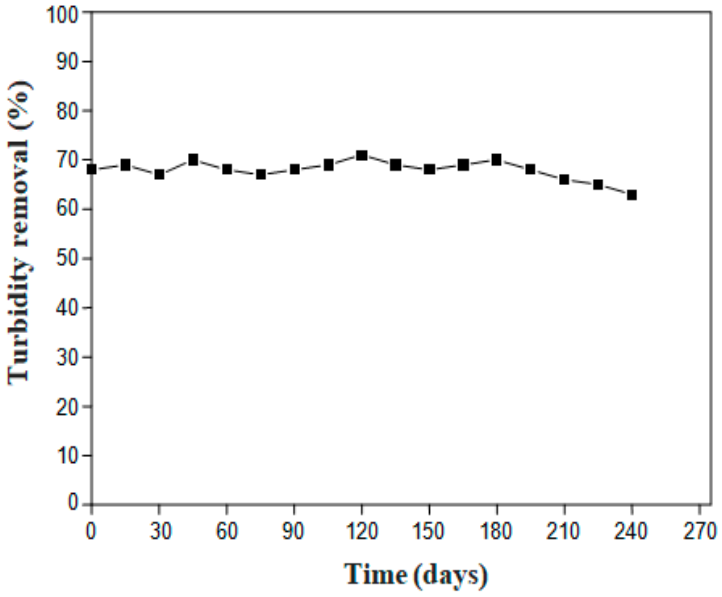
Figure 5. Effect of the LP storage period on the MB turbidity removal (MB concentration = 0.10 g/L, alum as coagulant: dose = 0.30 g/L, LP as flocculant: dose = 0.37 g/L).